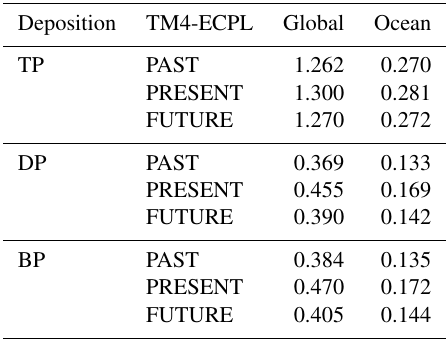
Table 4. Global and oceanic deposition fluxes of TP, DP and BP (in Tg-Pyr − 1 ) , as calculated by the TM4-ECPL model for PAST, PRESENT and FUTURE